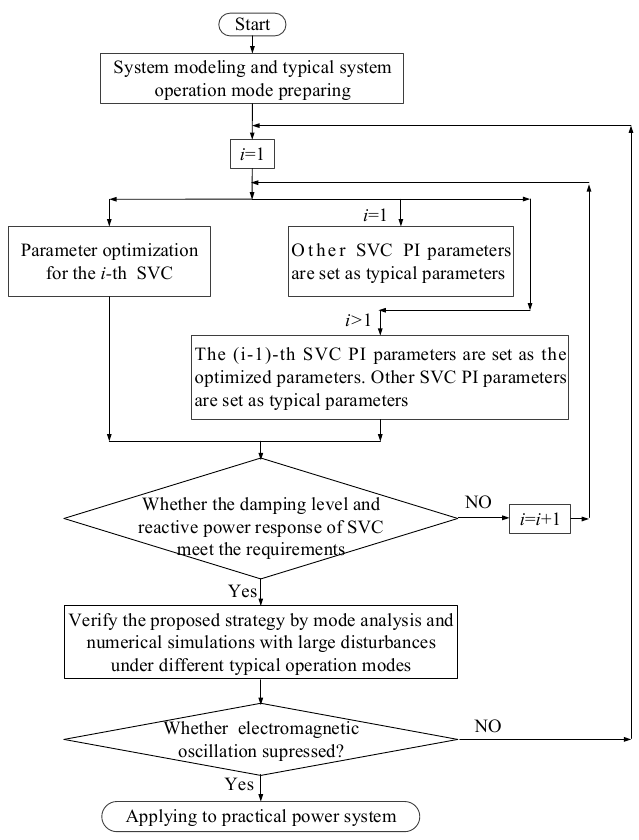
Figure 12. Multi-SVC parameter optimization process.